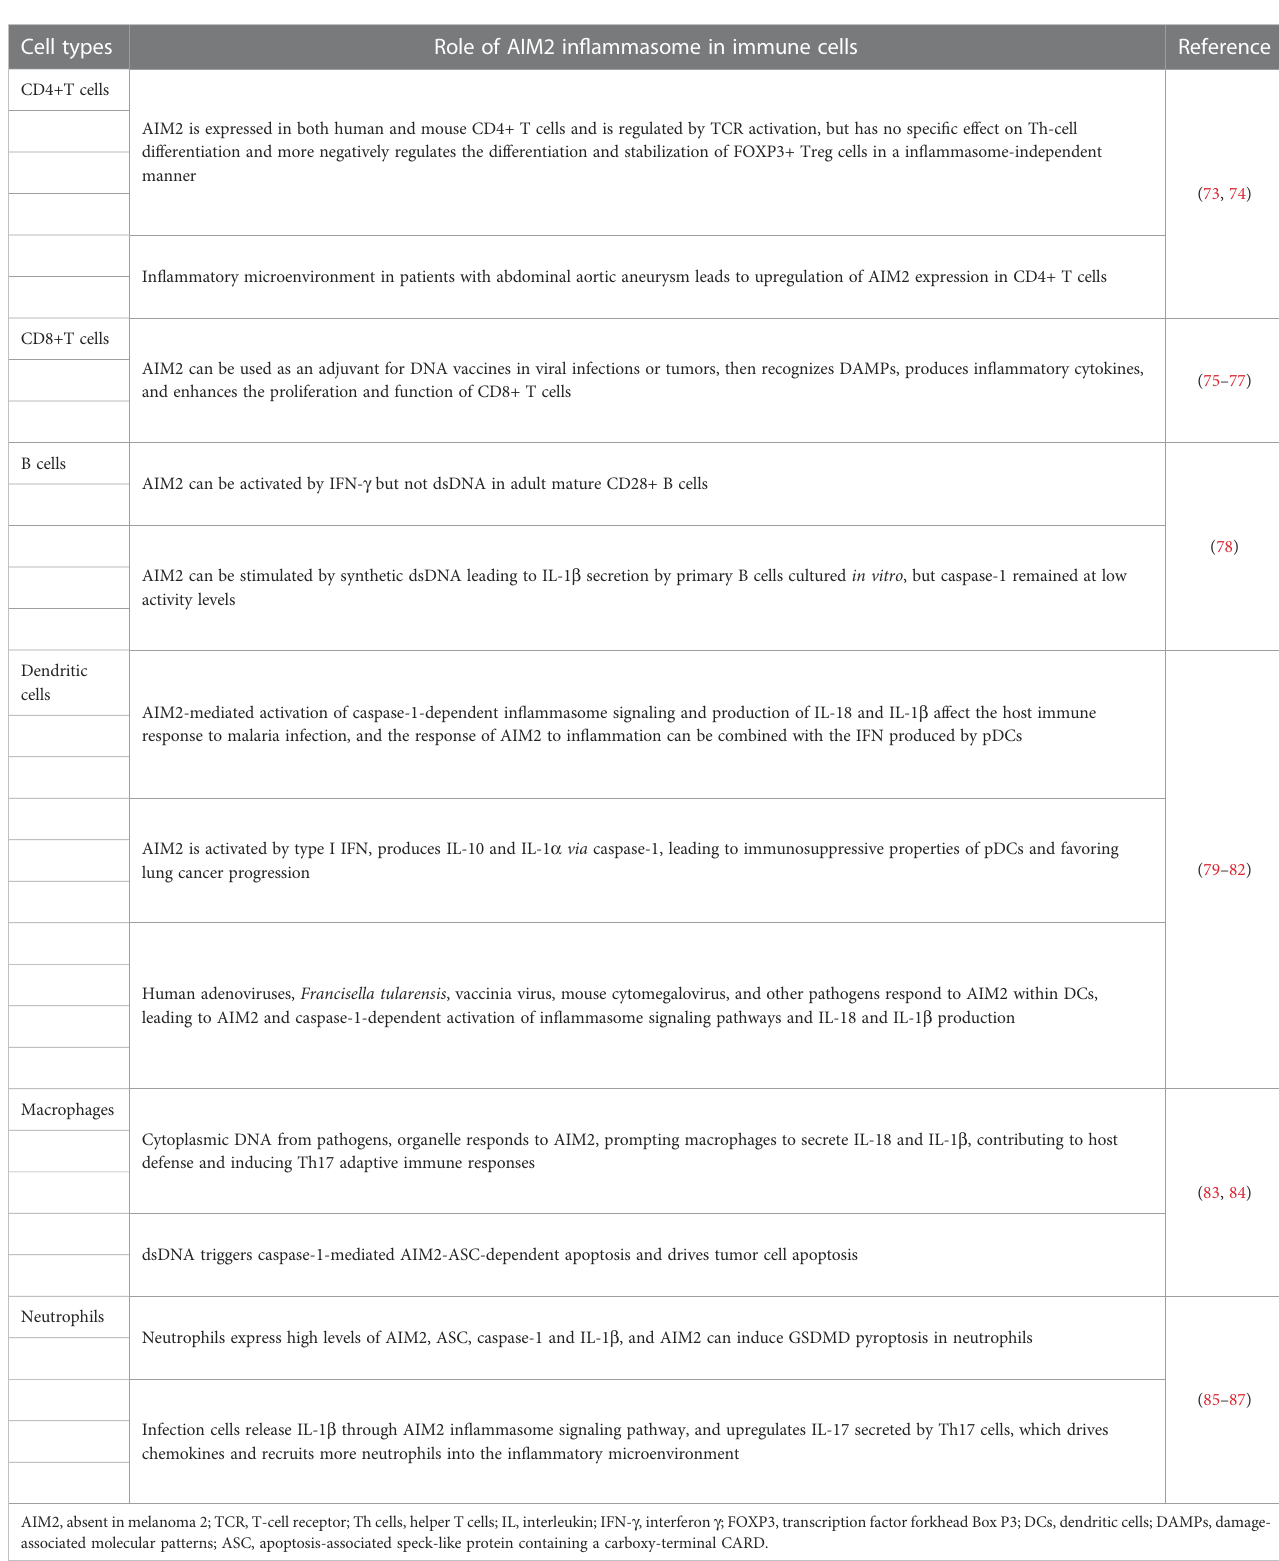
TABLE 1 The activation of AIM2-in fl ammasome in immune